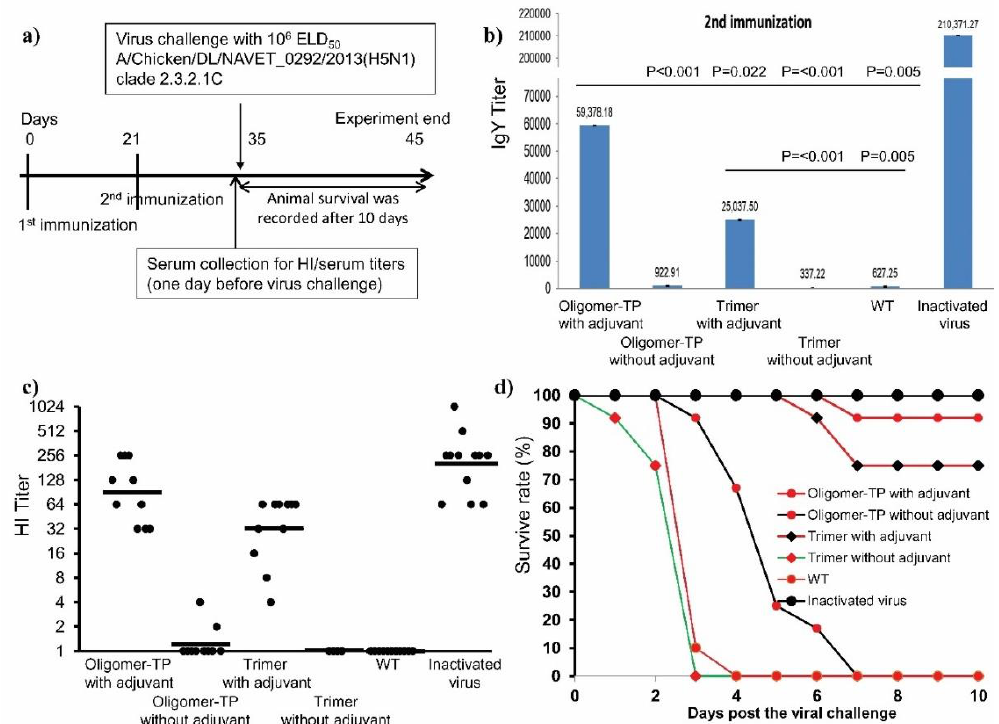
Figure 6. Immune responses of chickens immunized with plant crude extracts containing H5 trimers and H5 oligomers. ( a ) Chicken immunization scheme. Twelve chickens per group were intramuscularly immunized with adjuvant and non-adjuvant H5 oligomer-TP and H5 trimer plant crude extracts at days 0 and 21. The adjuvant WT plant crude extract (negative control) and inactivated virus (positive control) were included. Thirteen days after the second immunization, all chicken sera were collected for immune response analyses. Fourteen days after the second immunization, all chickens were challenged with HPAIV A/Chicken/DL/NAVET_0292/2013 (H5N1) at a 10 6 ELD50 dose. The chicken survival rate was recorded 10 days after viral challenge. Chicken sera collected after the second immunization and before virus challenge were analyzed on the basis of ELISA measuring the specific IgY titer ( b ), HI titer estimation ( c ) and the chicken survival rate ( d